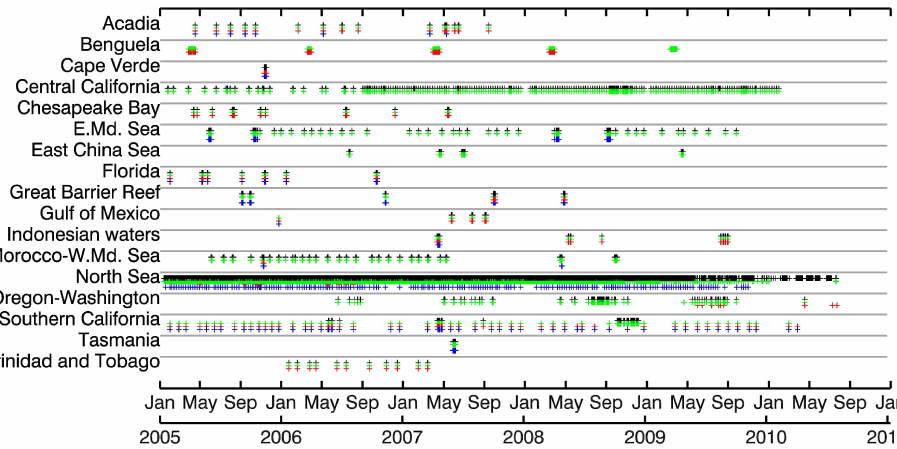
Figure 2. Time availability of at least one parameter available from the CoastColour sites within the match-up field measurements: metadata (black) (excluding the date, time, geographical coordinates, and data provider), biogeochemical data (green), AOPs (red), and IOPs